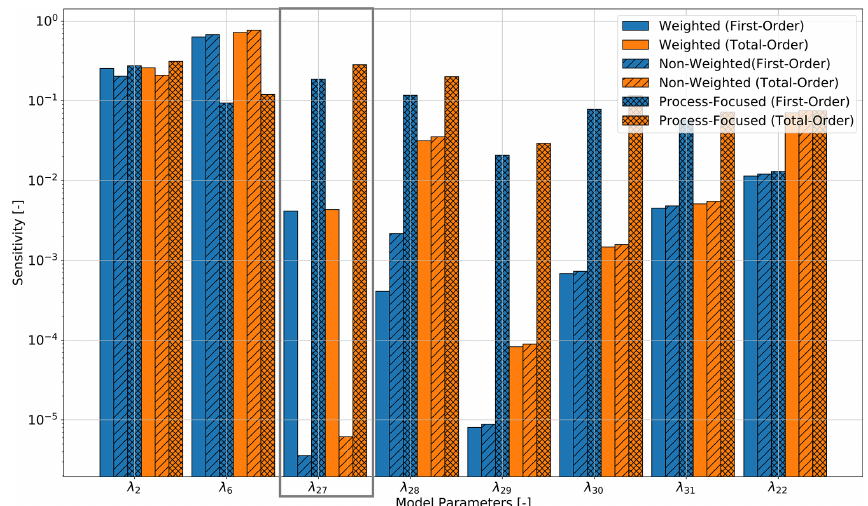
Figure 11. Sensitivity analysis of the unconsolidated sediments and lower crust with different weighting schemes of the hierarchical global sensitivity analysis for the General-Focus Alps model. For the layer IDs and symbols, please refer to Table